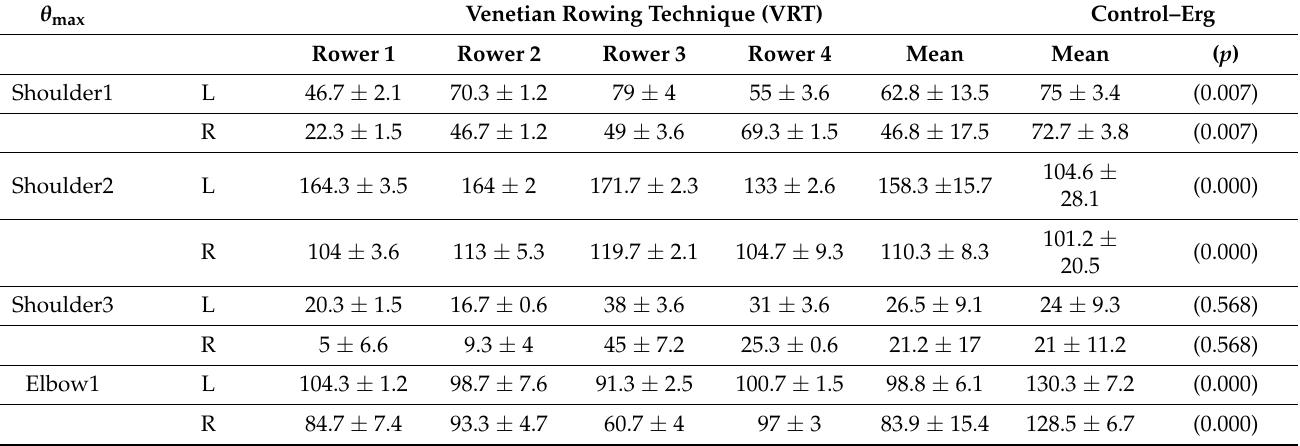
Table 9. The maximum values, θ max , of the shoulder and elbow angles measured for the Venetian style rowing technique, in degrees, ± 1 s.d., for the individual rowers 1–4, their mean, and its equivalent mean value for standard ergometer rowing, with p -value for these two means reported in